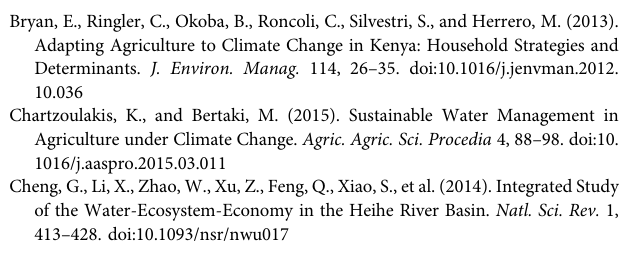
Frontiers in Environmental Science |